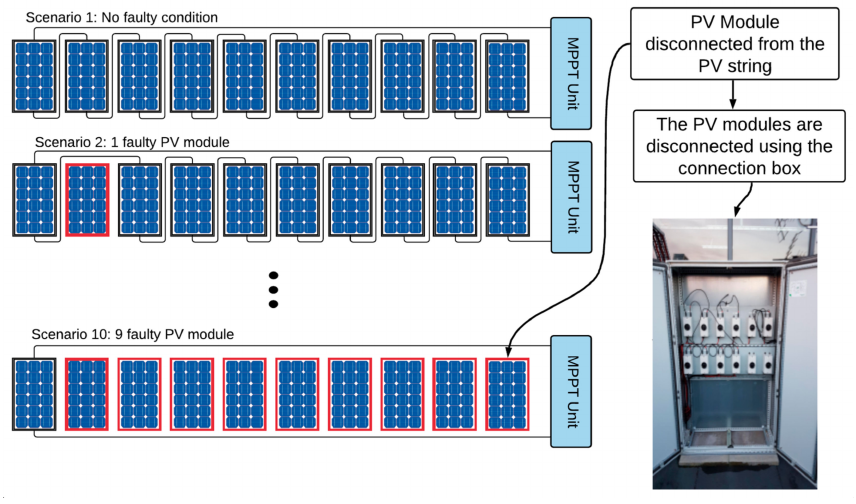
Figure 12. Experimental setup.